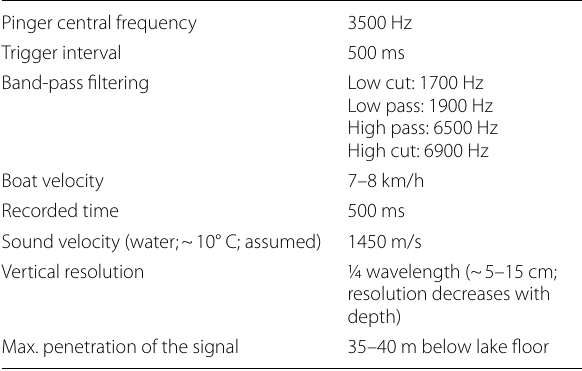
Table 2 Applied settings for the high-resolution seismic survey in 2018 Pinger central frequency 3500 Hz Trigger interval 500 ms Band-pass